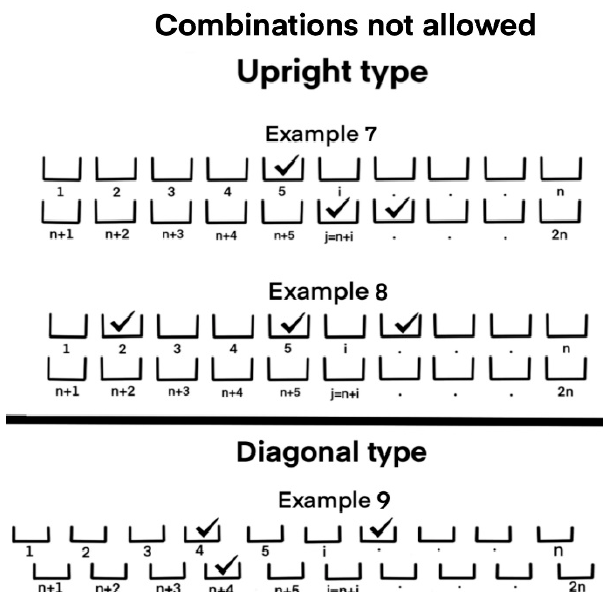
Figure 5. Combinations not allowed in the double-layered upright and double-layered diagonal machine configurations.